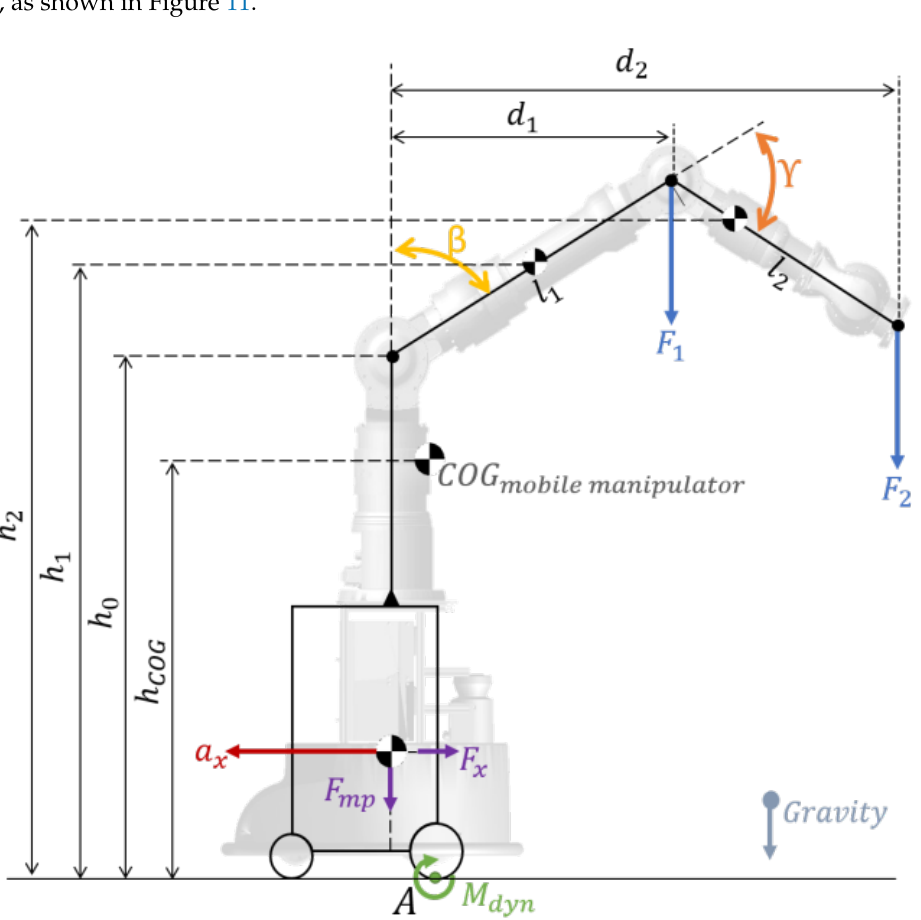
Figure 11. Free body diagram of mobile manipulator considering dynamic forces and moments generated by operation movements.